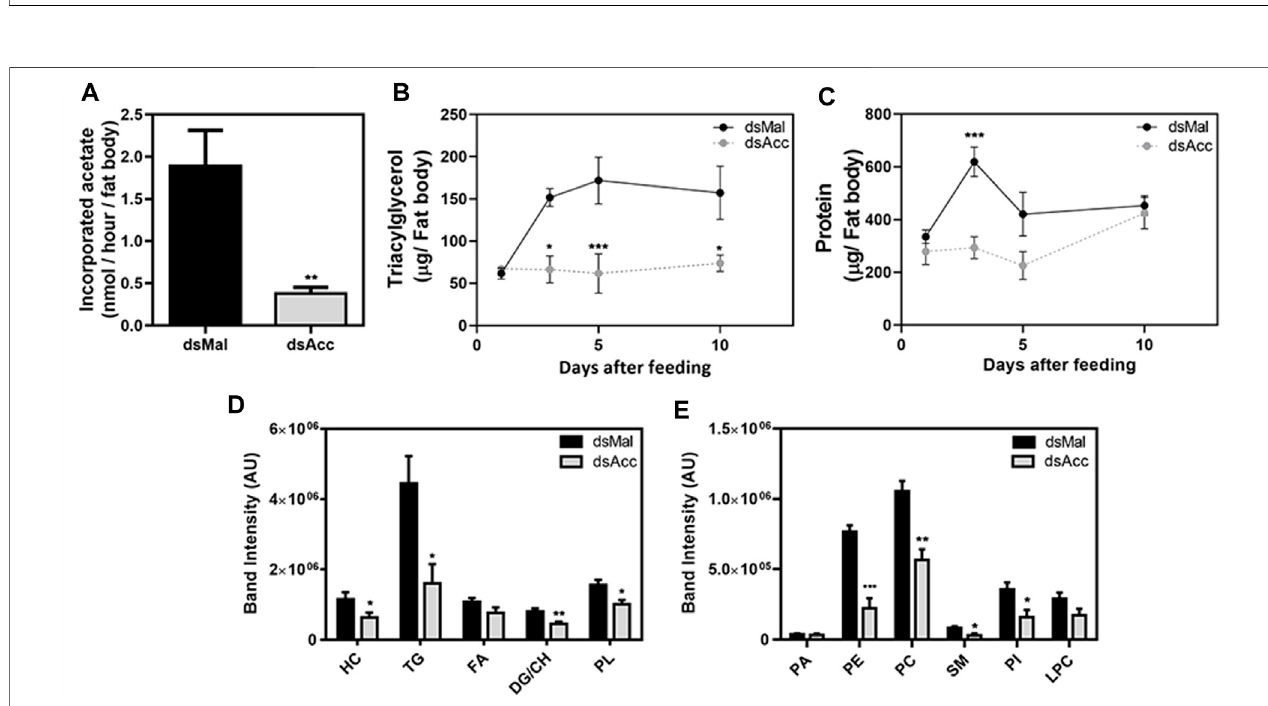
FIGURE 2 | Acc knockdown affected perimicrovillar membranes. Starving adult females were injected with 1 µg of dsRNA for Acc or Mal (control) and were fed 3 dayslater. Insects weredissected at10 days after blood meal,and themidguts were collected, washed, and processed forscanningelectron microscopy. (A) dsMal; (B)